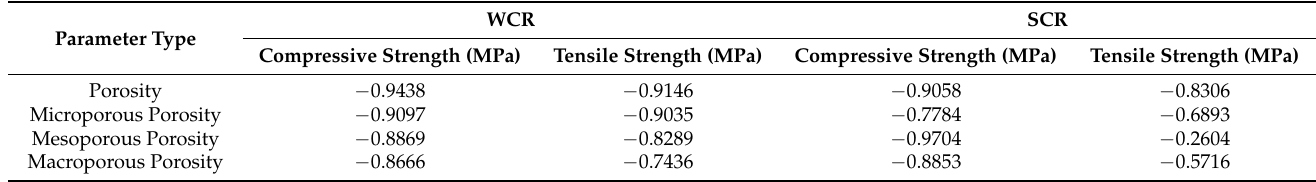
Figure 13. The influence of fractal dimension on compressive strength and tensile strength.